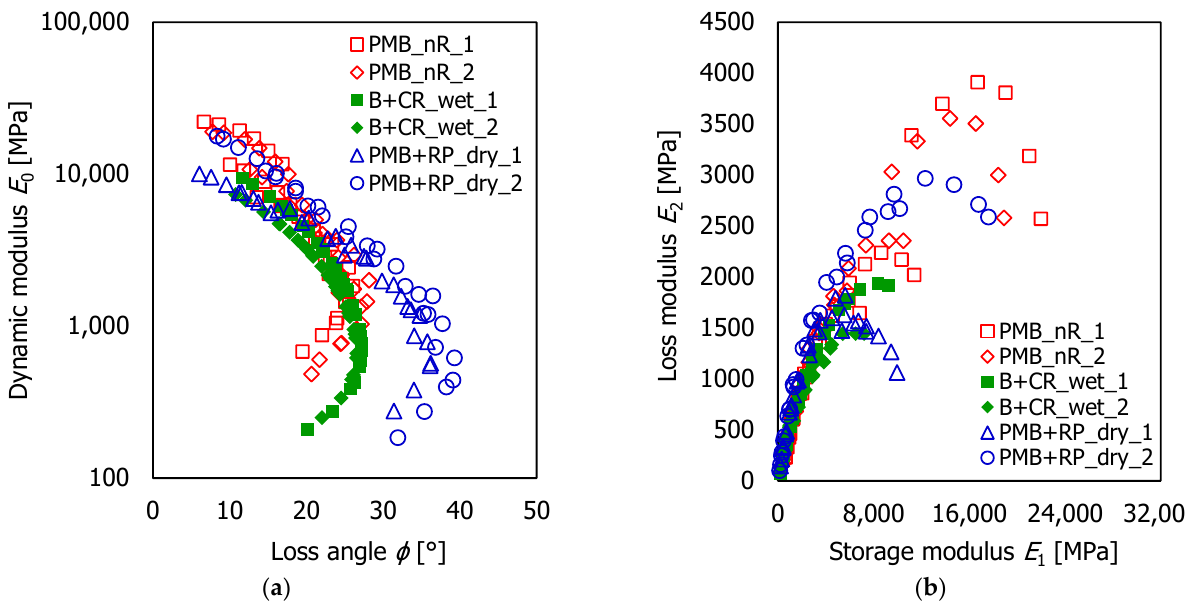
Figure 2. The measured values of E*: ( a ) in the Black space; ( b ) Cole-Cole diagram.